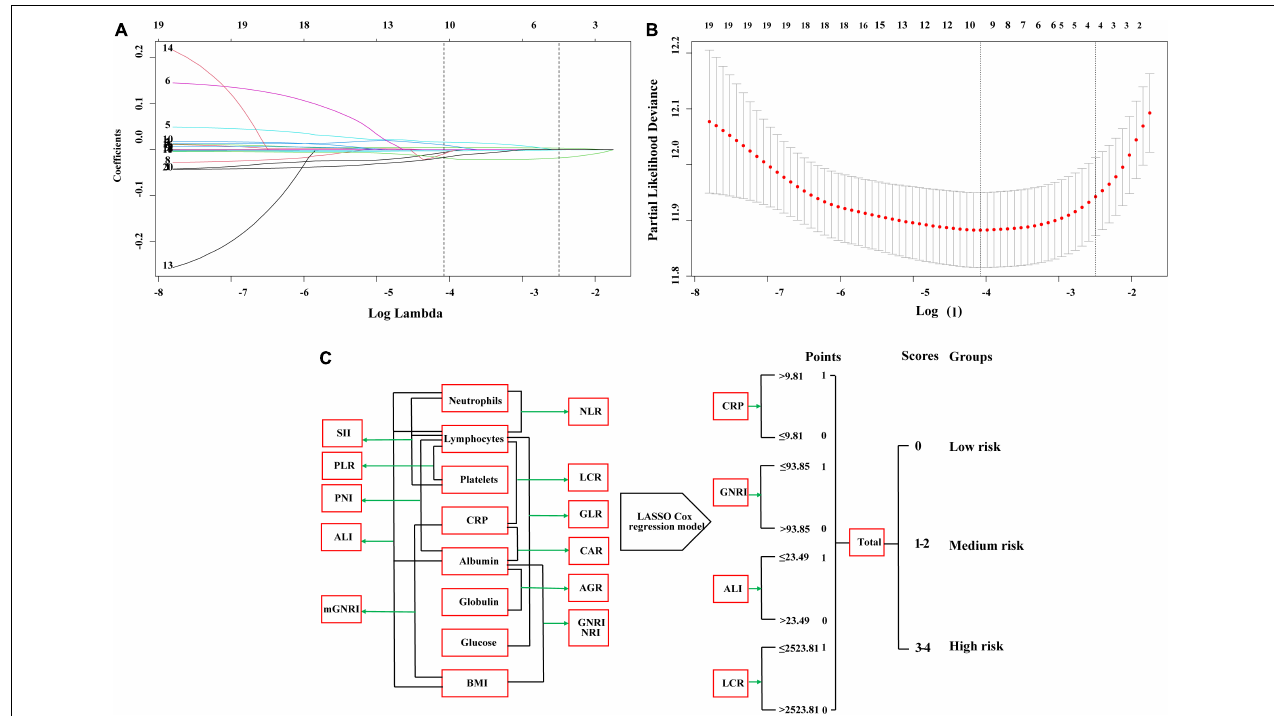
FIGURE 1 | The least absolute shrinkage and selection operator (LASSO) Cox regression model screening parameters, SIPS construction process, and risk stratification. (A,B) The LASSO Cox regression model screening parameters; (C) SIPS construction process and risk stratification. SIPS: systemic inflammation prognostic score; BMI: body mass index; CRP: C-reactive protein; NLR: neutrophil to lymphocyte ratio; PLR: platelet to lymphocyte ratio; GLR, glucose to lymphocyte ratio; ALI: advanced lung cancer inflammation index; SII: systemic immune inflammation index; CAR: C-reactive protein to albumin ratio; GNRI: geriatric nutrition risk index; mGNRI: modified geriatric nutrition risk index; AGR: albumin to globulin ratio; PNI: Prognostic Nutritional Index; NRI: nutrition risk index; LCR: lymphocyte to C-reactive protein